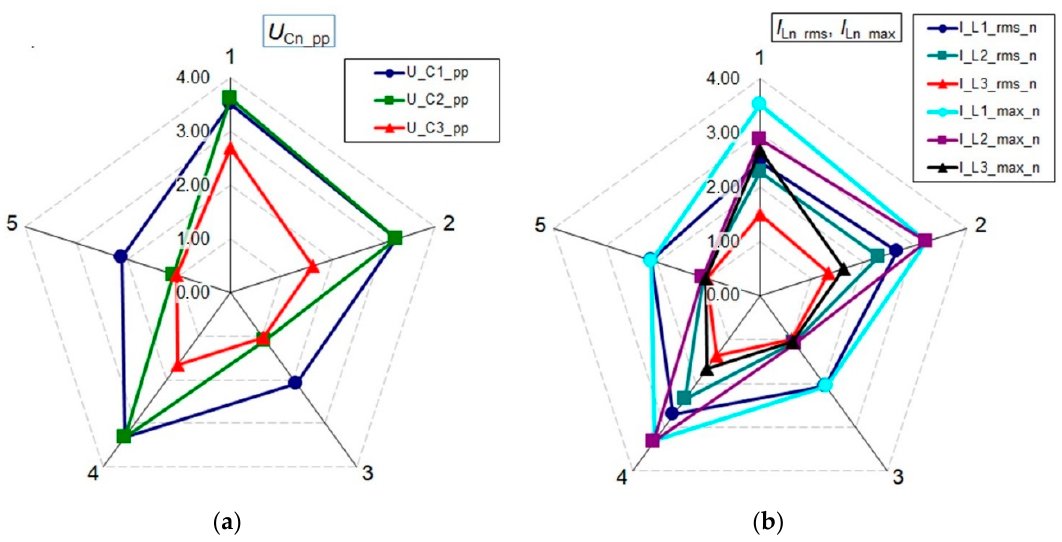
Figure 9. Ratios of the following parameters of strategies C1–C5 (axes 1–5): ( a ) Peak-to-peak voltages across capacitors C 1 – C 3 , ( b ) rms and maximum values of currents in inductances L 1 – L 3 . The results are based on the data in Table 3.